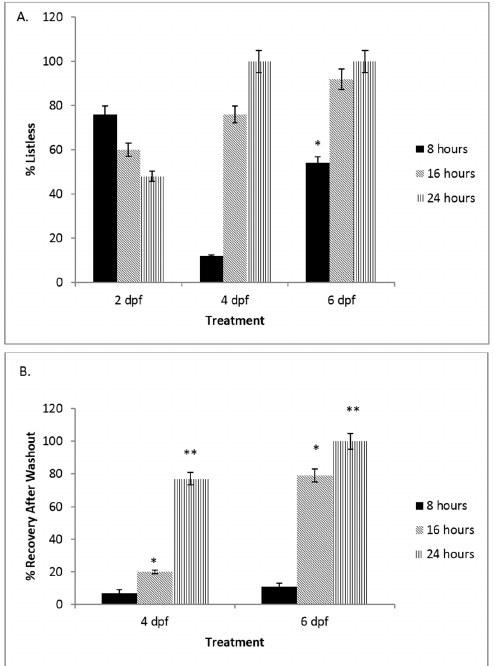
Figure 1. Analysis of the most desirable developmental age to study NO deprivation in the 2–6 days post fertilization (dpf) zebrafish. ( A ) The effect of developmental age on embryonic zebrafish response to 50 µ M NO synthase inhibitor (nNOSI) in developing the ‘listless’ phenotype. After 24 h of treatment, only 50% of fish at 2 dpf express the phenotype compared to 100% of both the 4 and 6 dpf groups (* p < 0.05). Additionally, note that there is no significant difference in the generation of the phenotype between the 4 and 6 dpf groups (* p > 0.05), except for the early phenotype acceleration at 8 h post treatment in the 6 dpf fish (* p < 0.05). Furthermore, the 2 dpf response to nNOSI treatment is not robust and is significantly less (* p < 0.05) than that exhibited by 4 and 6 dpf fish; ( B ) fish can quickly recover from the listless symptoms caused by nNOSI treatment. Specifically, fish treated with nNOSI at 6 dpf for 24 h and washed out with ERS recover 100% of their sensory-motor functions compared to only 80% of 4 dpf treated fish (* p < 0.05). Bars equal ± standard deviation